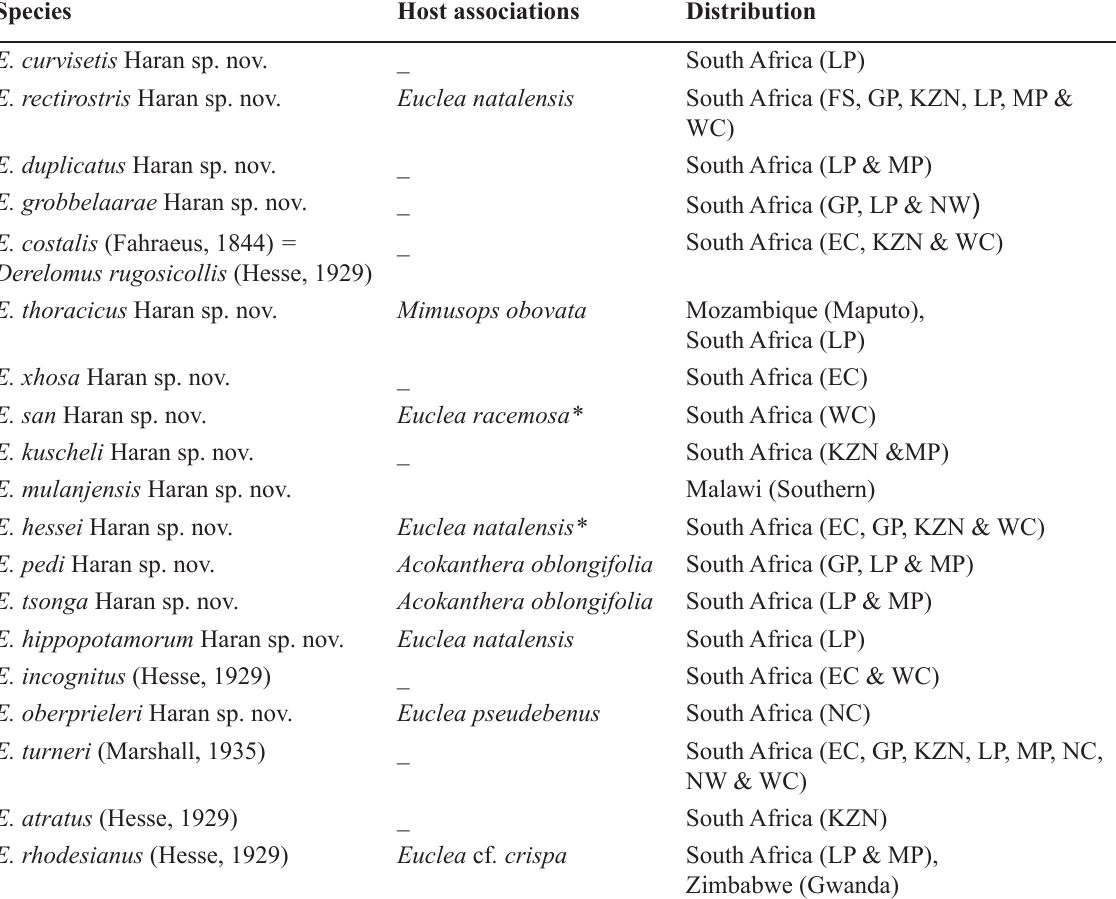
Table 1. Summary of plant associations and distribution of species of Ebenacobius Haran gen. nov. Plants marked with an asterisk indicate that larval stages of the species were obtained from flower tissues. Provinces of South Africa: EC = Eastern Cape; FS = Free State; GP = Gauteng; KZN = Kwazulu-Natal; LP = Limpopo; MP = Mpumalanga; NC = Northern Cape; NW = North West; WC = Western Cape.